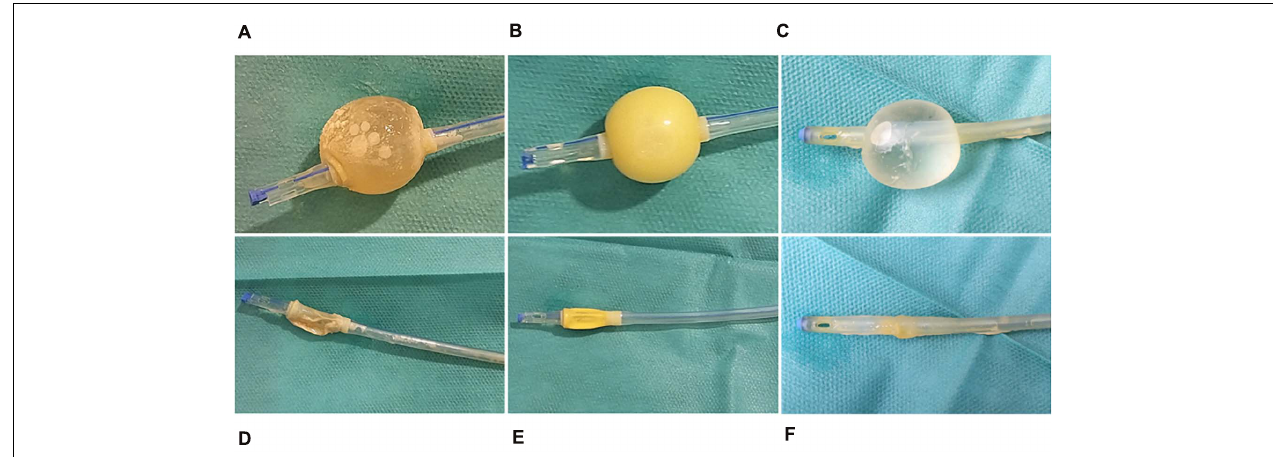
FIGURE 7 | Catheters posttreatment. Catheters were removed at termination for visual inspection of the balloon and shaft. (A,D) Control; (B,E) interpenetrating polymer network (IPN)-C; (C,F) BIP-C.